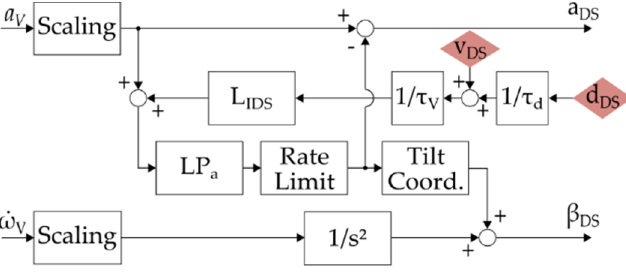
Figure 3. Ideal motion cueing algorithm, based on [5] (p. 51).